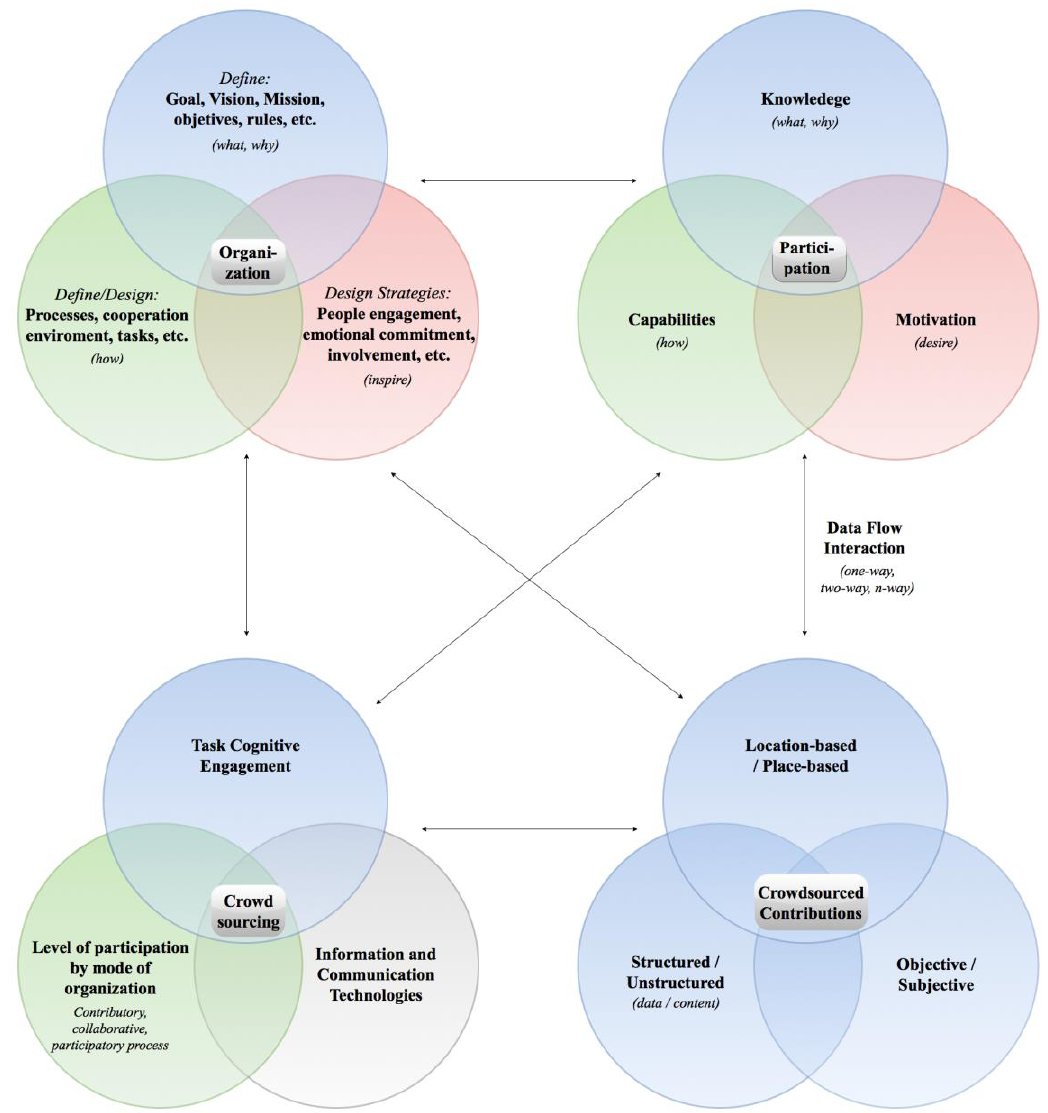
Figure 7. Interdependent Aspects in VGI Management and Production.